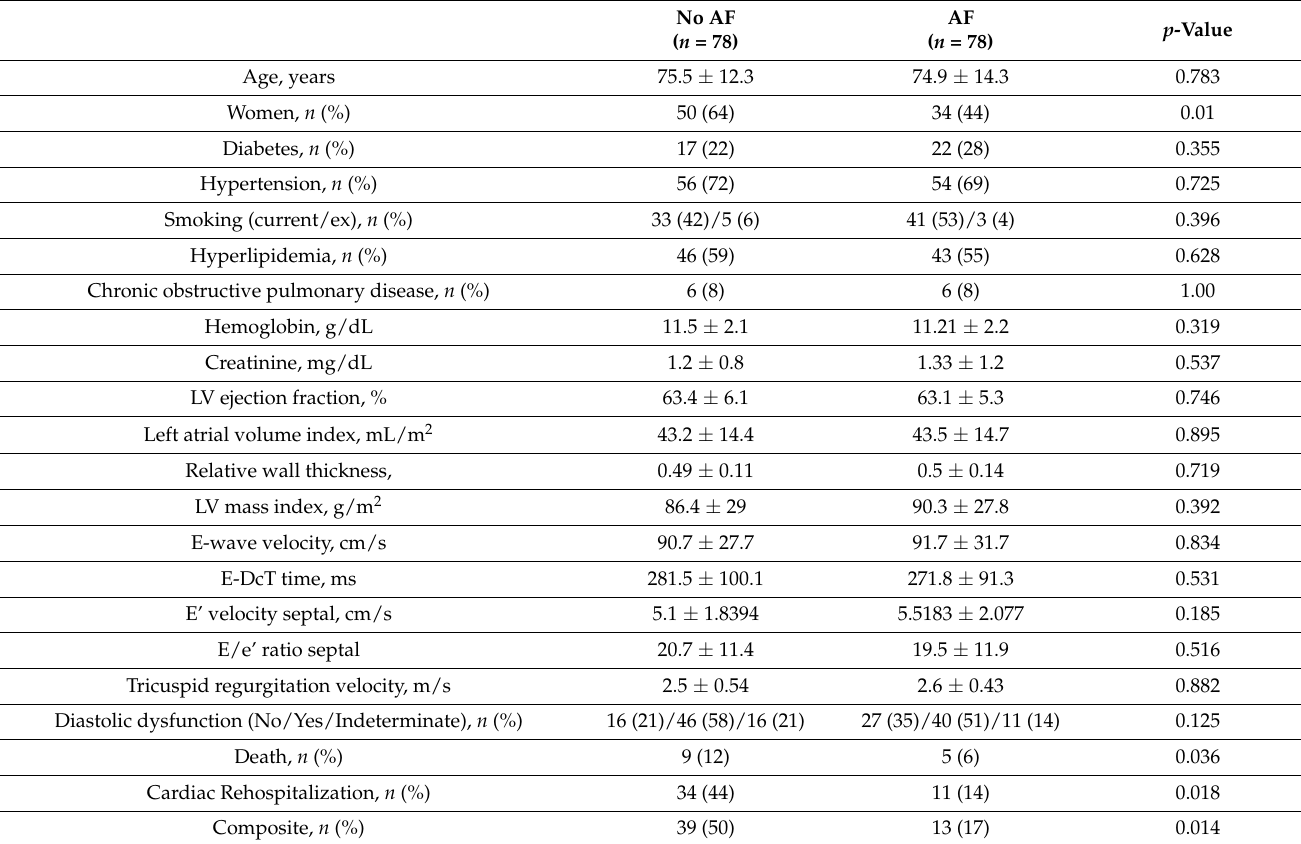
Table 4. Demographic, clinical and echocardiographic data in women and men after 1:1 propensity score